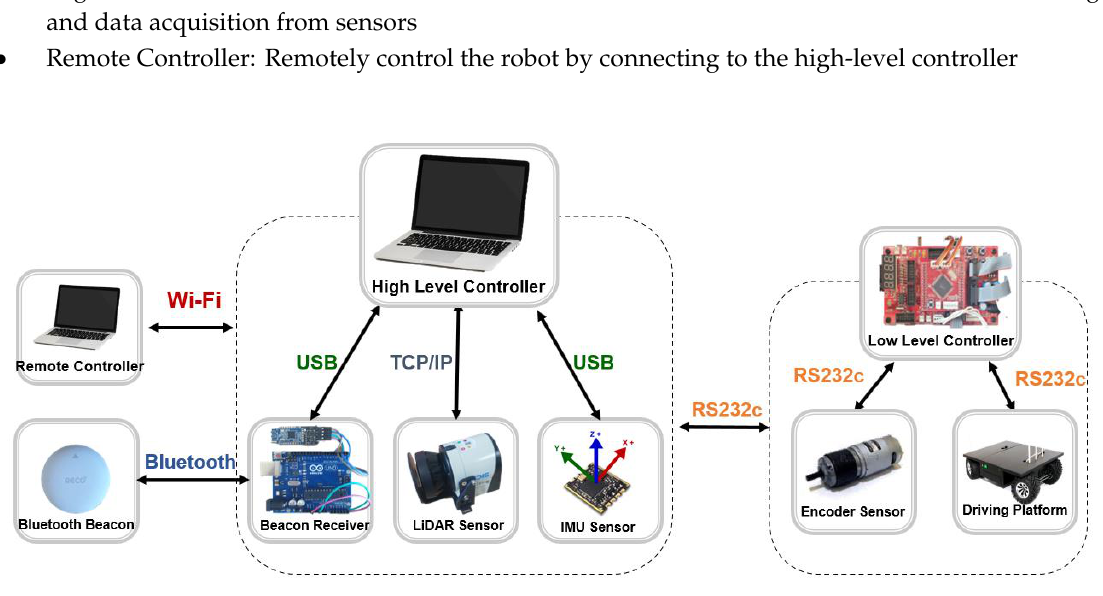
Figure 1. Overall structure of the autonomous driving robot used in this study. The high-level controller communicates with the low-level controller via the RS232C method; the remote controller is connected wirelessly through Wi-Fi communication. A Bluetooth beacon, which is a Bluetooth-based wireless communication device, was used to enable the robot to stop automatically at the destination. The Bluetooth beacon used in the study was the RECO beacon (Perples, Seoul, Korea), and the HM-10 module was used as the Bluetooth signal receiver. LiDAR, IMU and